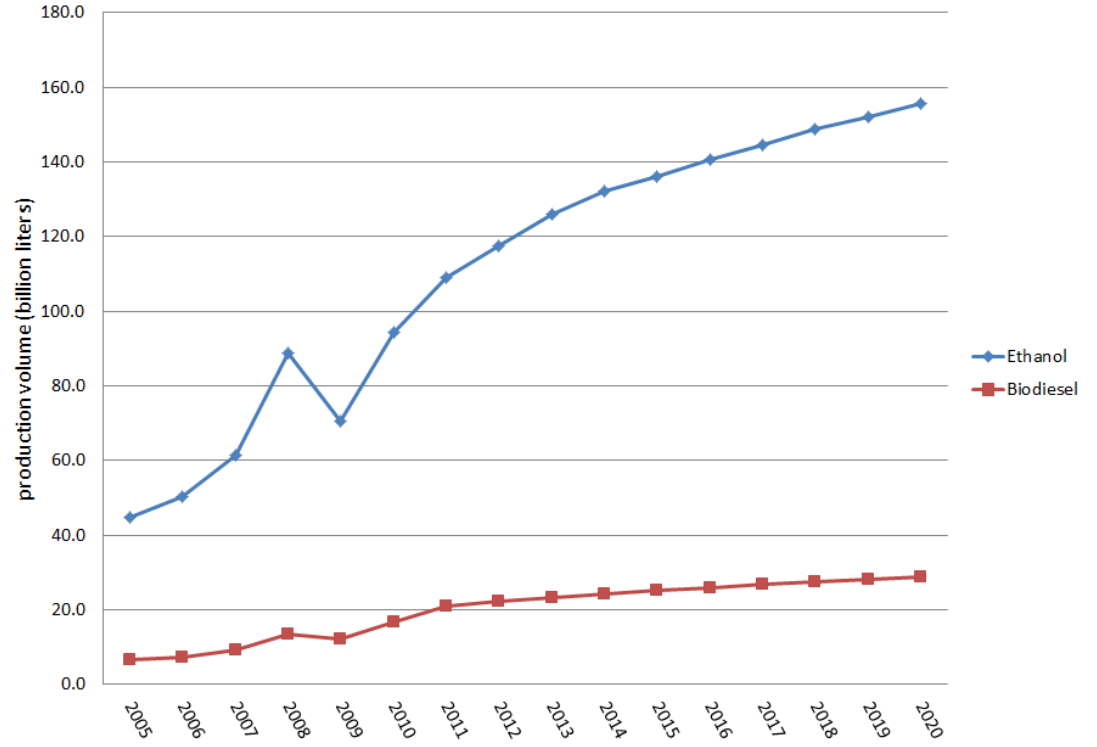
Figure 4. Global ethanol and biodiesel production under baseline